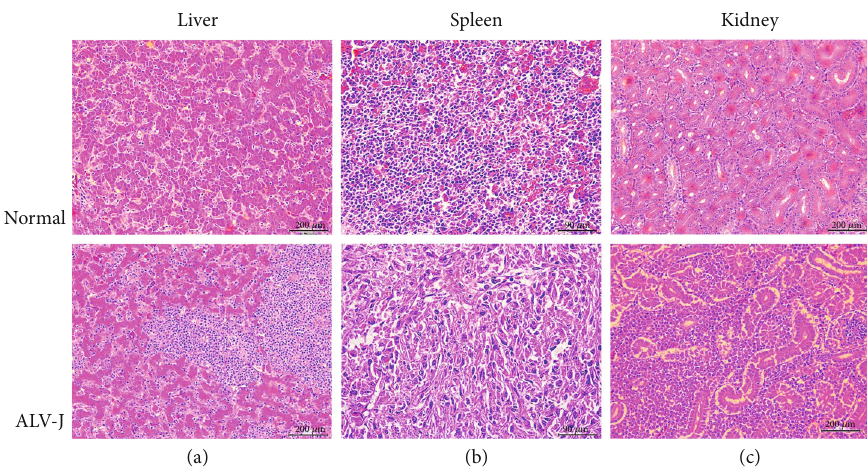
Figure 1: Histopathological changes in the clinical samples (hematoxylin and eosin staining). Comparisons between the normal group and ALV-J infection for (a) liver ( bar = 200 μ M ), (b) spleen ( bar = 90 μ M ), and (c) kidney ( bar = 200 μ M ) morphology of the